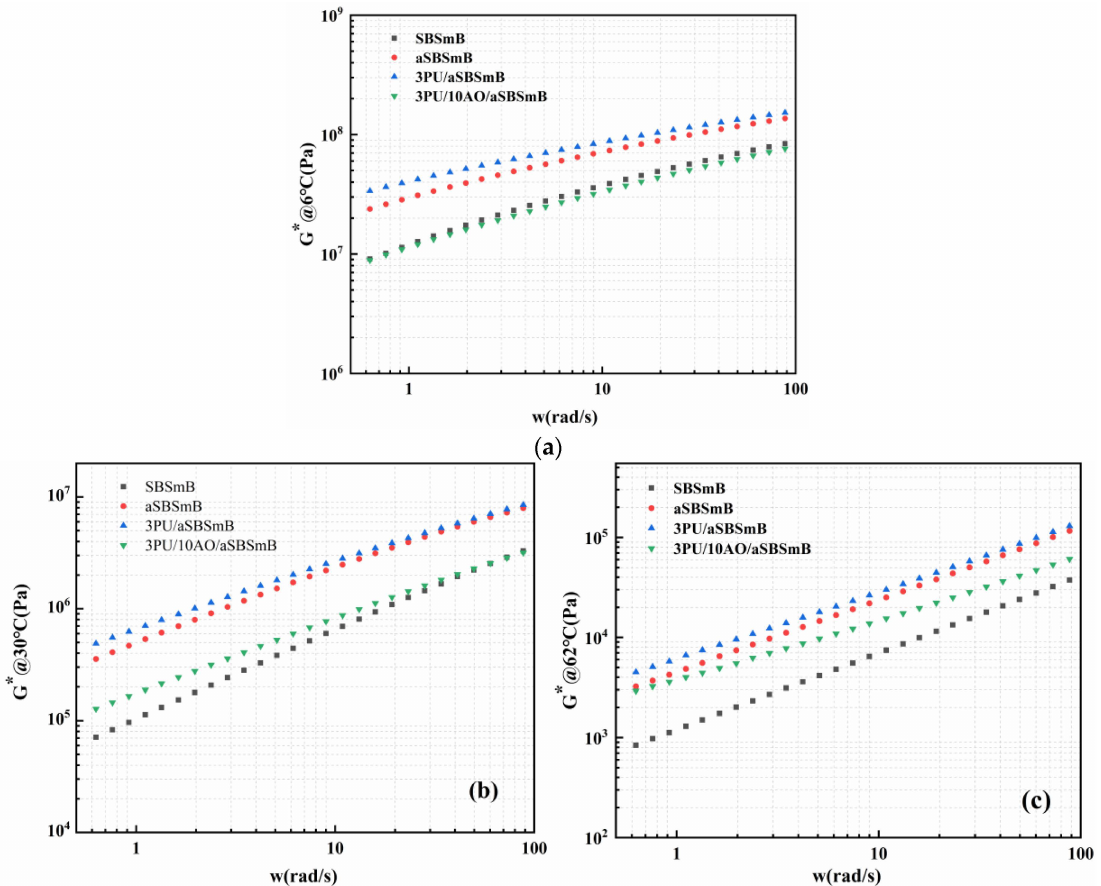
Figure 10. Frequency response to viscoelastic behavior of reaction-rejuvenated SBSmB at various temperatures: ( a ) low temperature, 6 ◦ C; ( b ) medium temperature, 30 ◦ C; ( c ) high temperature, 62 ◦